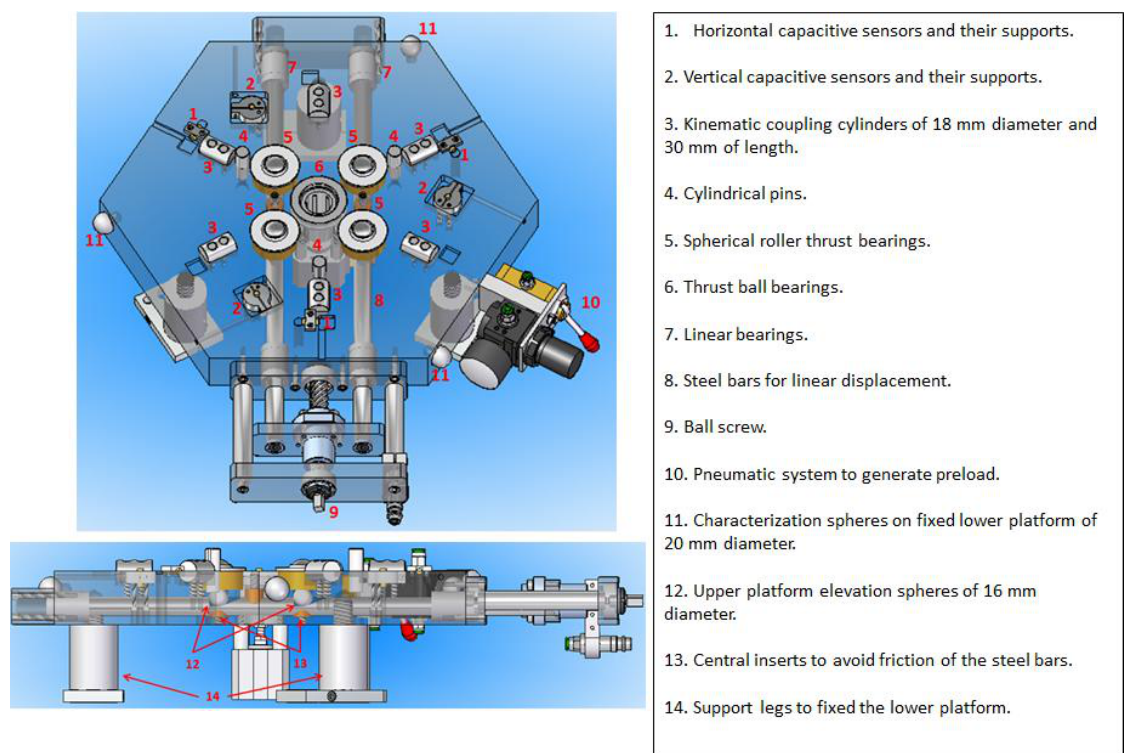
Figure 4. Fixed lower platform mechanical